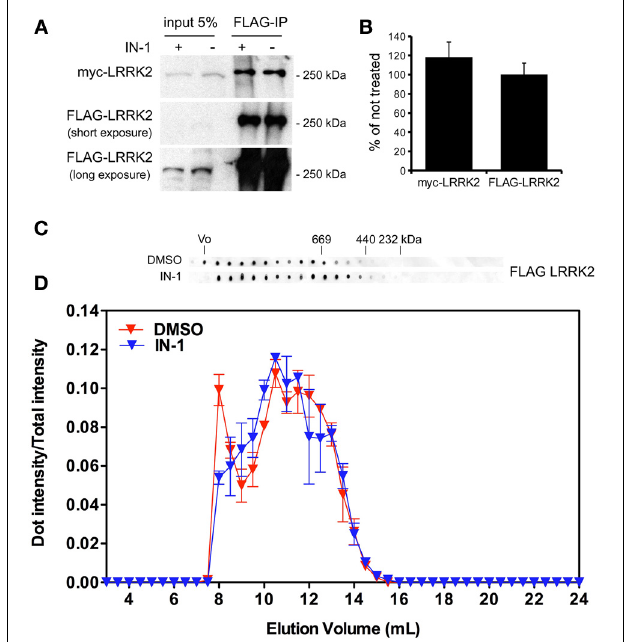
FIGURE 5 | IN-1 does not influence LRRK2 dimerization. (A) HEK293T cells expressing both myc and FLAG LRRK2 were treated or not with IN-1 (2 µ M for 2h), solubilized and processed for FLAG immunopurification. We evaluated the extent of LRRK2 homodimerization by measuring the amount of myc LRRK2 co-precipitating with FLAG LRRK2 (B) The graph reports the amount of FLAG and myc LRRK2 recovered in FLAG immunoprecipitates upon IN-1 incubation. Data were calculated as fraction of untreated sample and expressed as mean ± s.e.m. ( n = 4). (C) Full-length LRRK2 purified by Flag immunoaffinity from untreated HEK293T cells was separated by size exclusion chromatography (SEC) and subsequently treated or not with IN-1 (1 µ M, 90min on ice). (D) The intensity of each dot (fraction) is normalized by the integrated intensities. Column void volume is